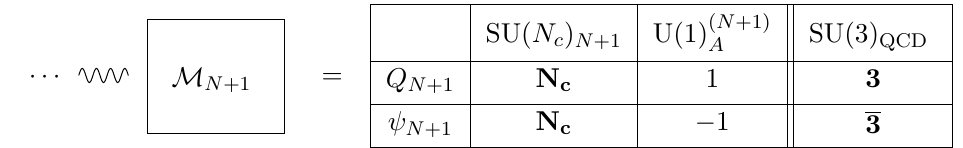
Table 7 . The termination of the chain of WiFi-connected